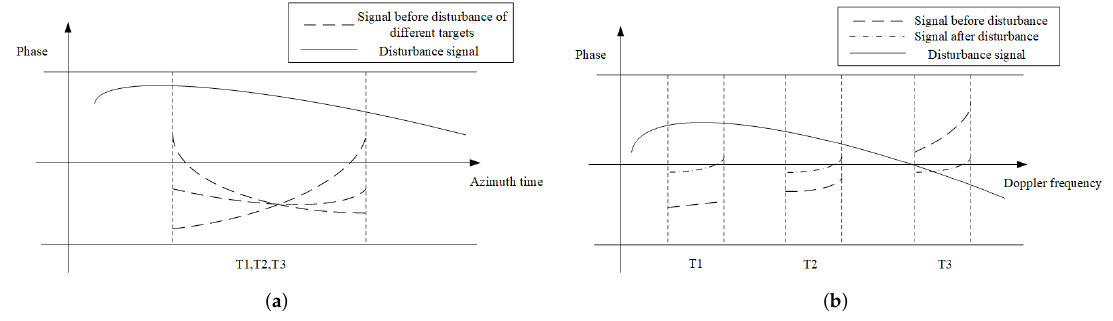
Figure 9. Cross-range support zones of different targets under the spotlight mode. ( a ) Support zone in the time domain. ( b ) Support zone in the frequency domain.